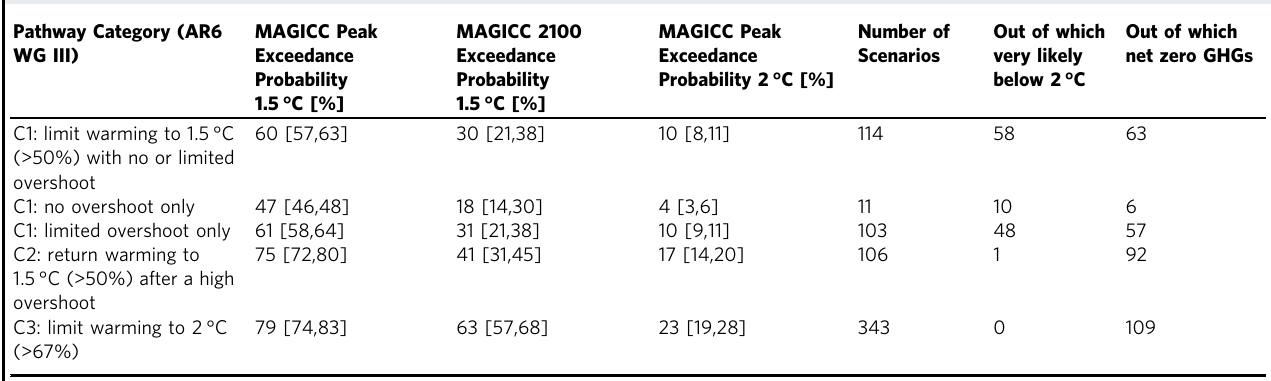
Table 1 Characteristics of pathways categories following the emission pathway classi fi cation in the IPCC AR6 Working Group 3